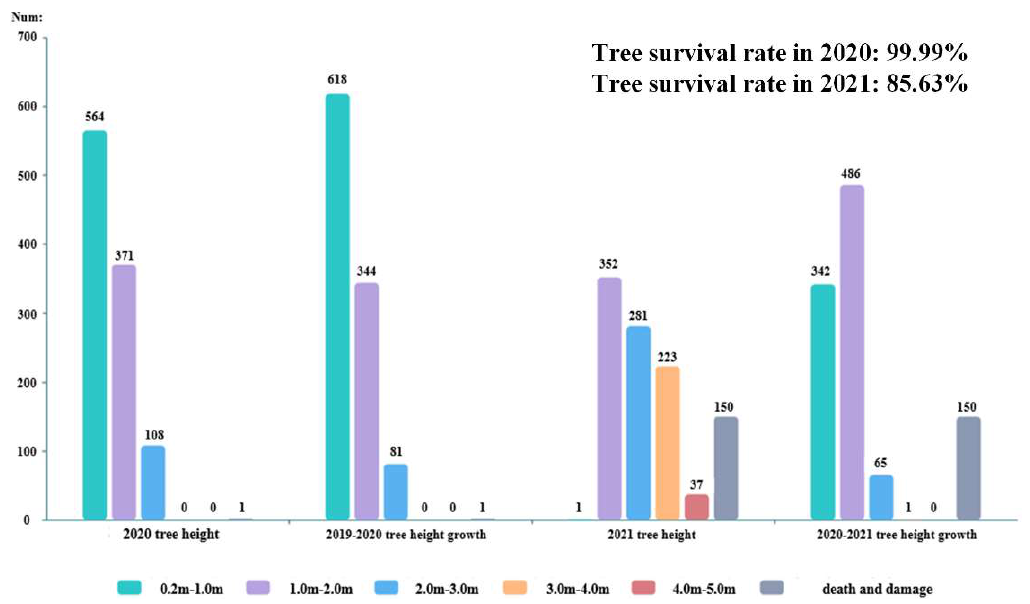
Figure 13. The different heights and growth of the young trees from 2019 to 2021.